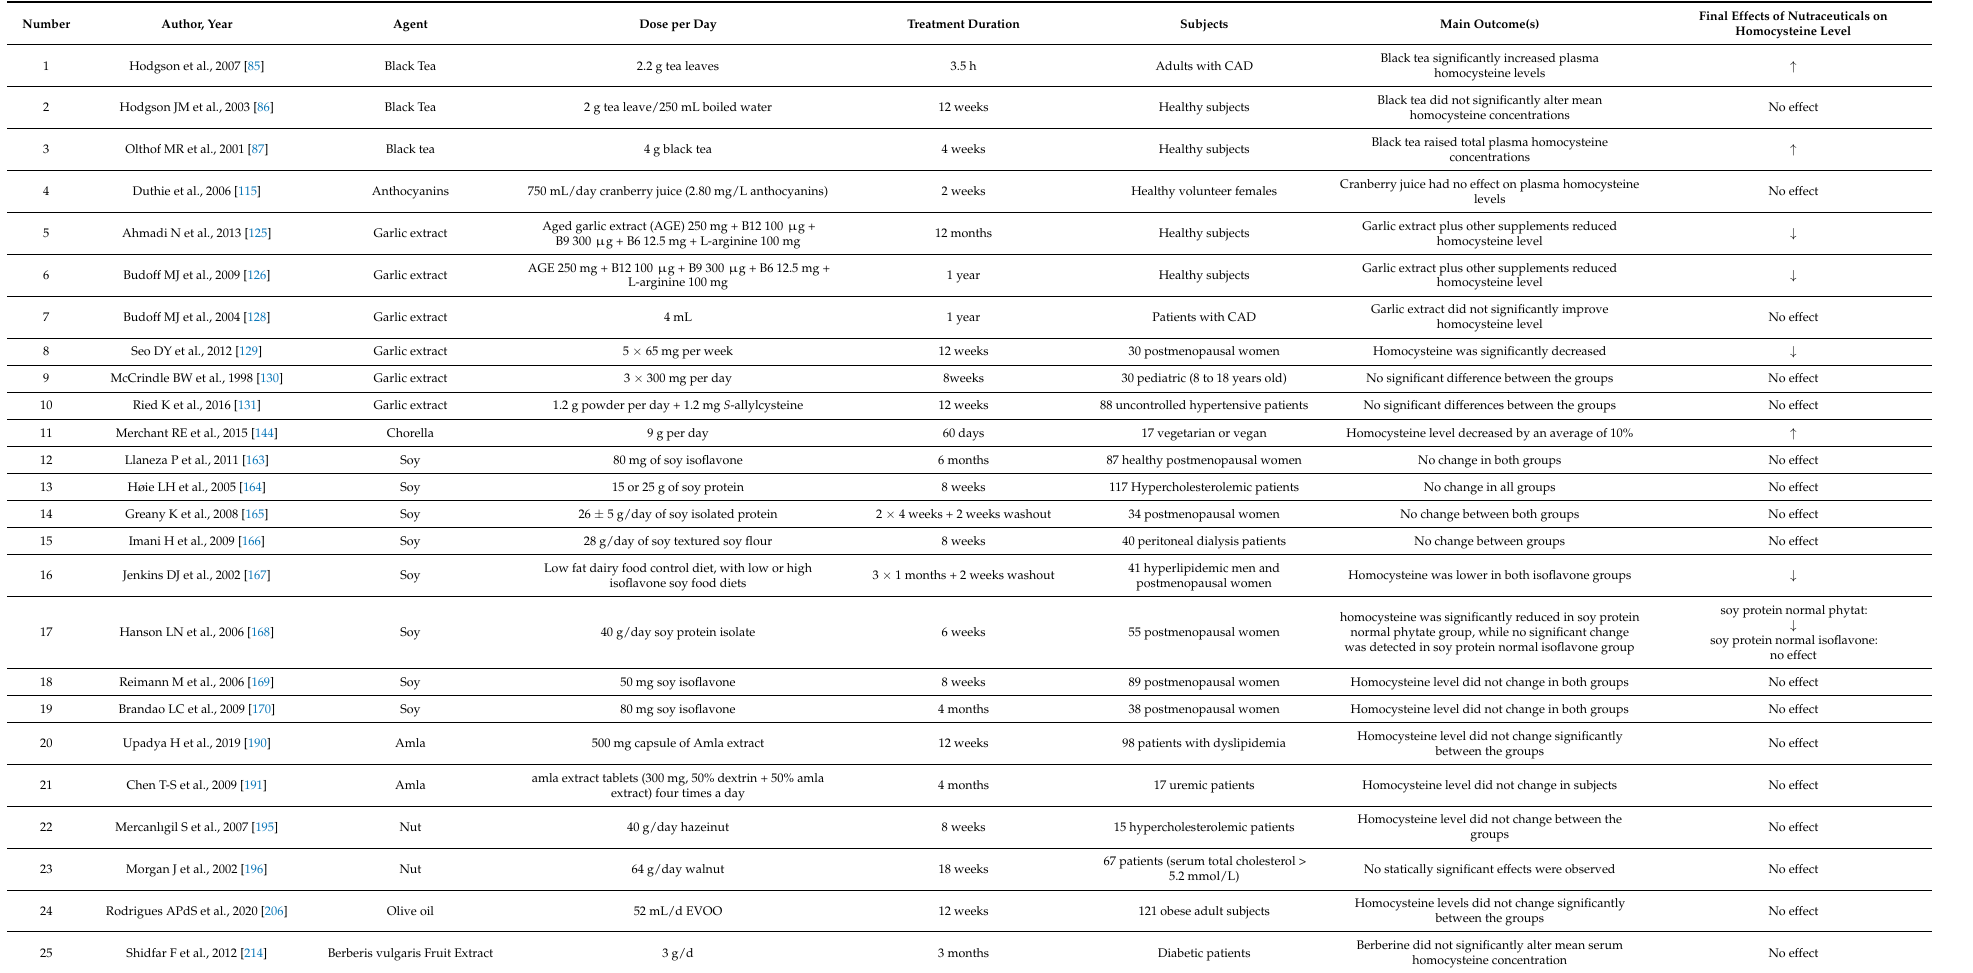
Table 1. The effects of herbal bioactive compounds on homocysteine levels according to clinical